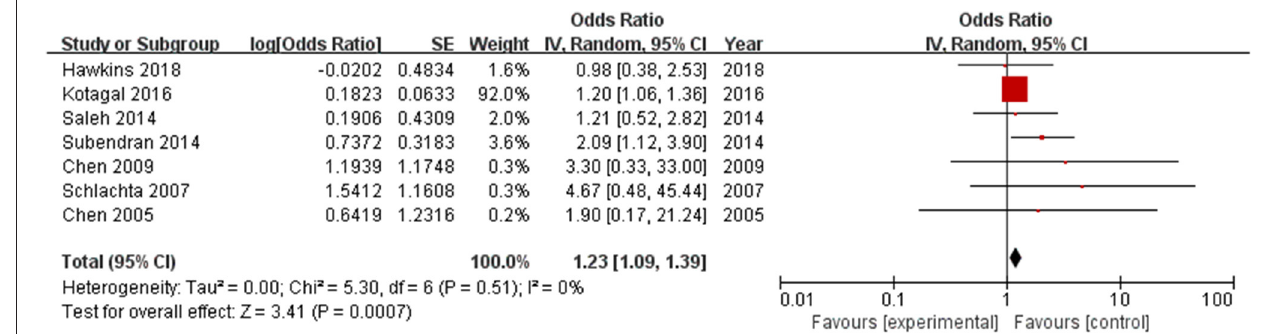
FIGURE 3 | Forest plots of anastomotic leak rate in the intervention and control groups.